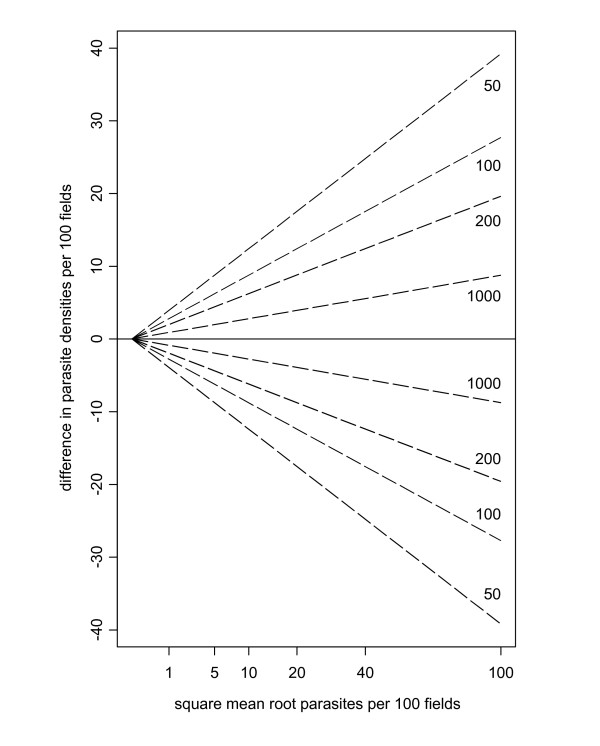
Limits of agreement are wider when less blood is examined. Ideal limits of agreement in terms of a standard volume of 100 fields. Each pair of dashed lines shows the limits of agreement for differing numbers of fields actually read, with the densities converted to the standard volume. The larger the volume read, the narrower the limits of agreement.